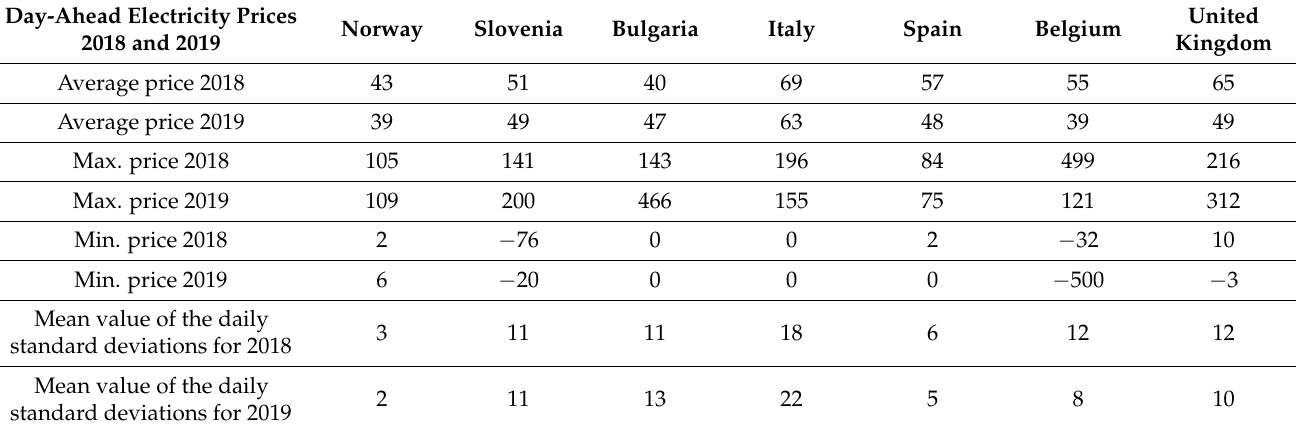
Table 3. Maximum, minimum, average value, and mean value of the daily standard deviations